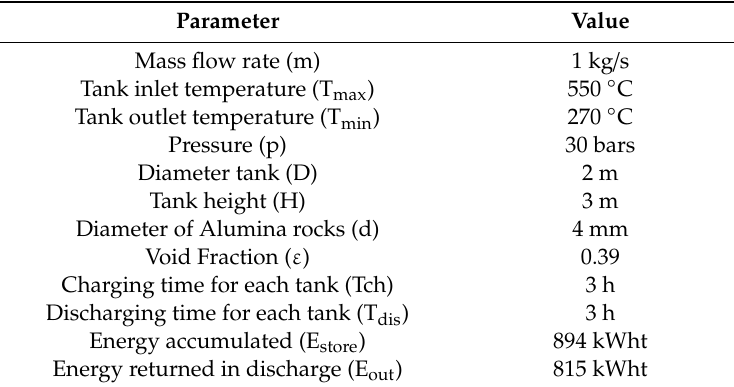
Table 5. Storage section parameters.